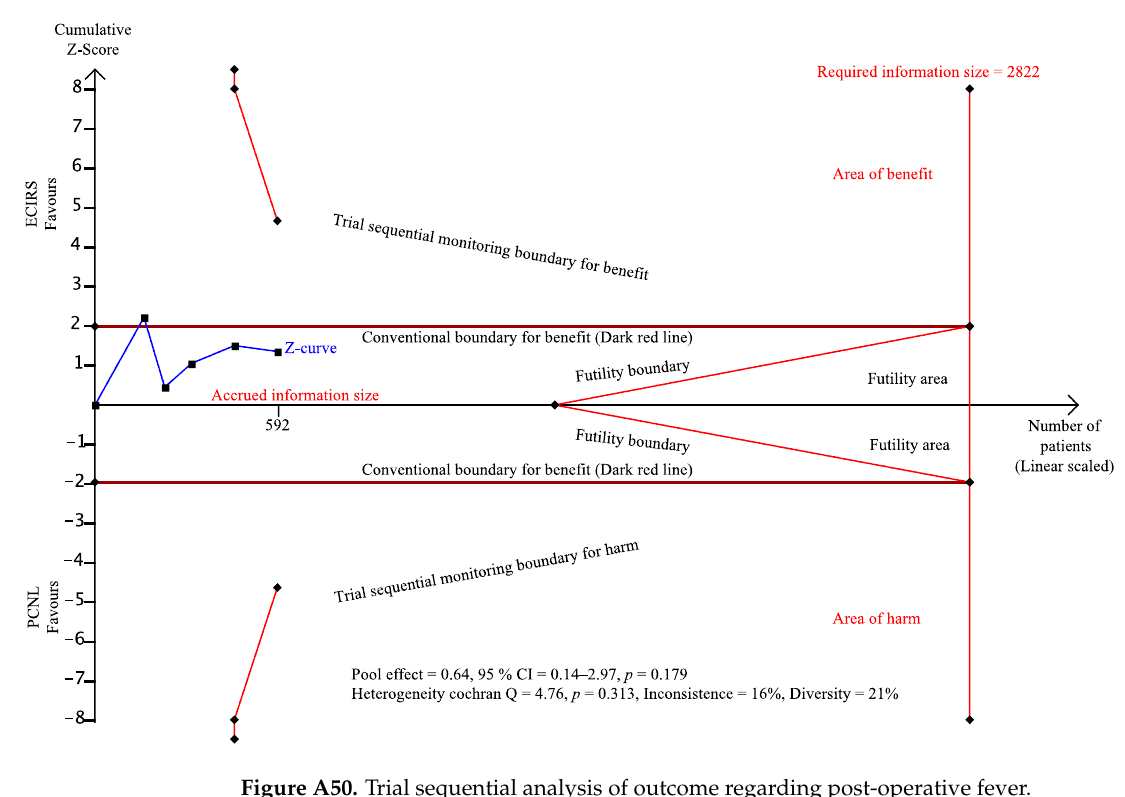
Figure A49. Trial sequential analysis of outcome regarding severe complications.